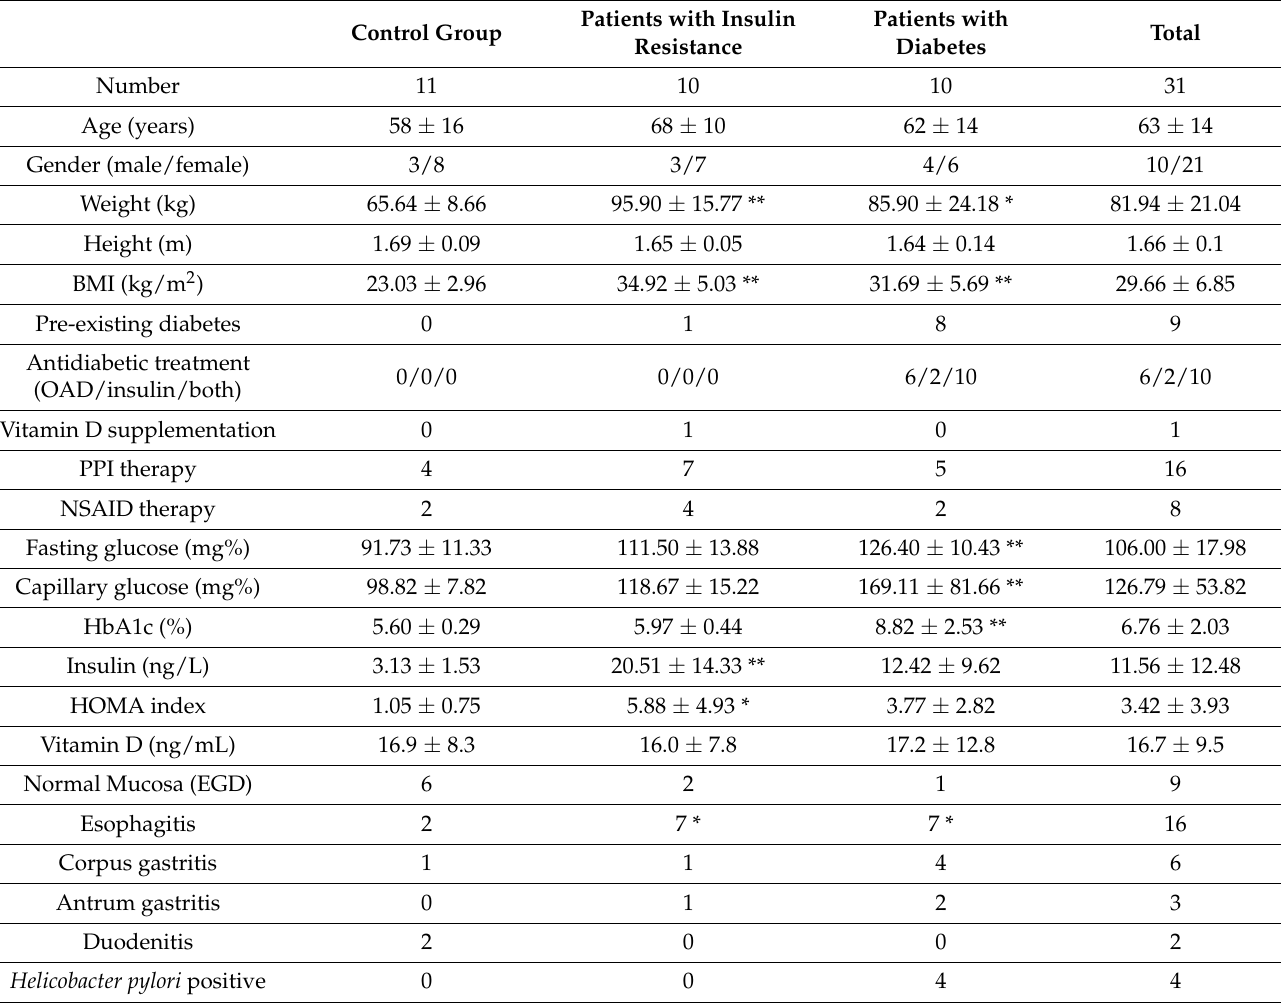
Table 2. Baseline characteristics of the study cohorts.